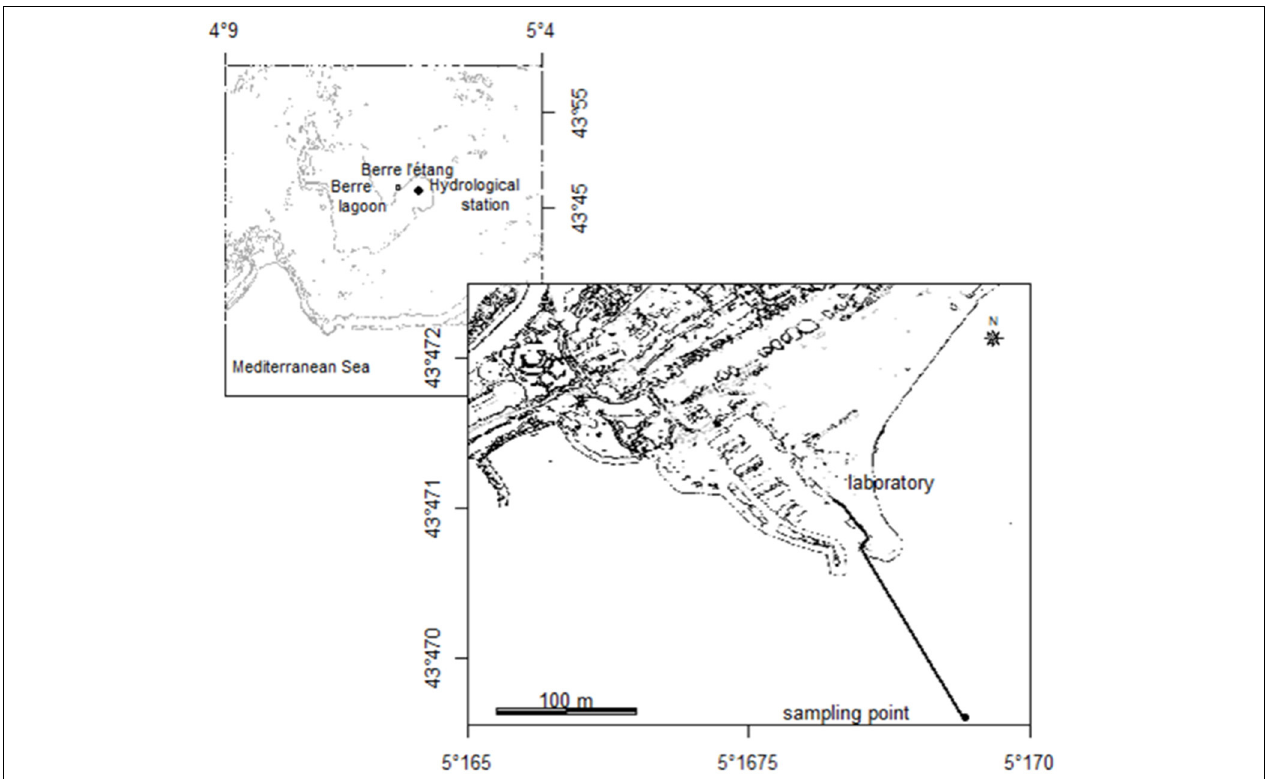
FIGURE 1 | Location of the sampling point (black circle) and the 250m pipe (black line) to pump the water to the laboratory, settled on the Berre l’étang